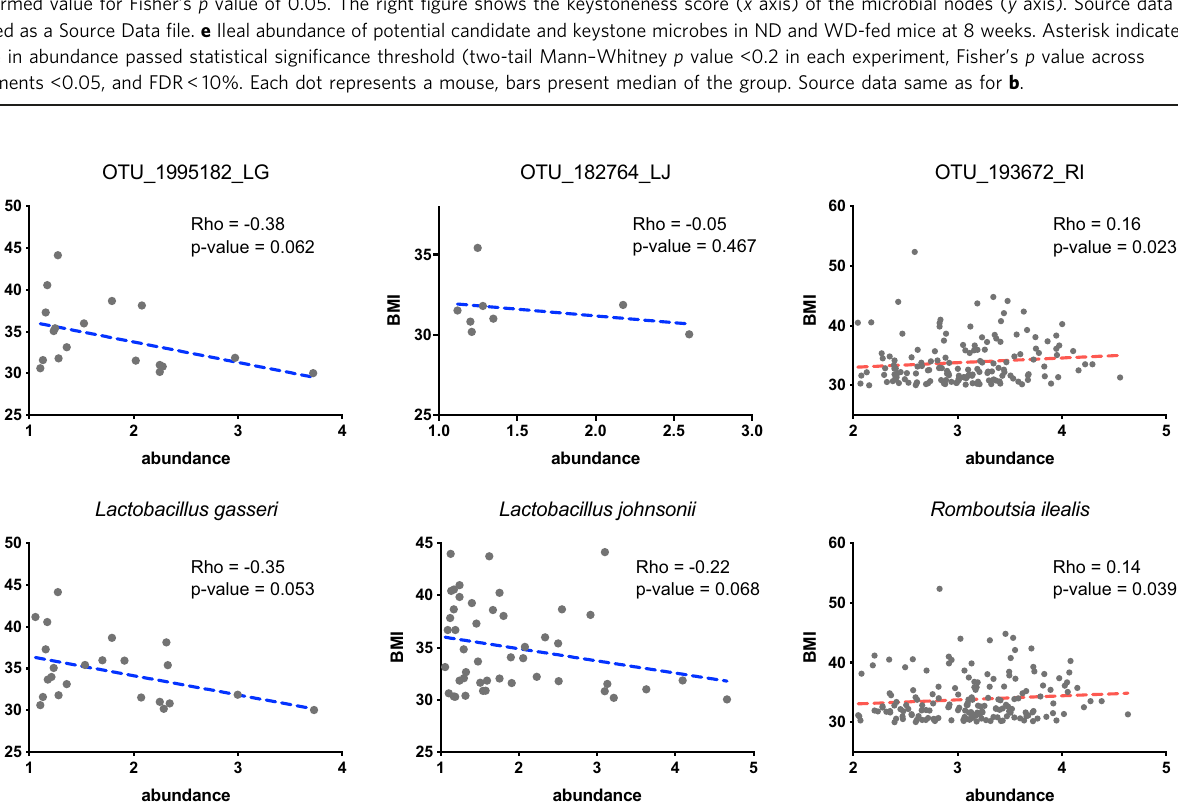
Fig. 1 Inference of gut microbes affecting glucose metabolism in the host. a The red and blue colors indicate higher and lower levels of metabolic parameters measured in mice fed normal diet (ND) or western diet (WD) at 4 and 8 weeks. Source data are provided as a Source Data fi le. b Principal Component Analysis of stool (triangle) and ileal (circle) microbial communities of mice on ND (blue) or WD (red). Source data are available at https:// www.ncbi.nlm.nih.gov/sra/?term = PRJNA558801. c The microbe and host parameter nodes are represented by circles and squares, respectively, in the transkingdom (TK) network. Red and blue colors of nodes indicate increased and decreased (WD/ND) fold change, respectively, whereas the size of circle represents frequency of microbe in stool of WD mice. The black and green node borders indicate the microbes were signi fi cantly increased or decreased, respectively, in ileum of WD mice compared with ND (Fisher ’ s p value across experiments <0.05). The orange and black edges indicate positive and negative correlations, respectively. The degree distribution of the TK-network follows a power law. The blue line indicates the fi tted line. Source data are available at https://tinyurl.com/TK-NW-Fig-1C. d The left two fi gures allow inference of microbial candidates that are potentially improvers (left fi gure) or worseners (middle fi gure) using high values of TK-network property (bipartite betweenness centrality (BiBC) on the x axis) and signi fi cance of change in